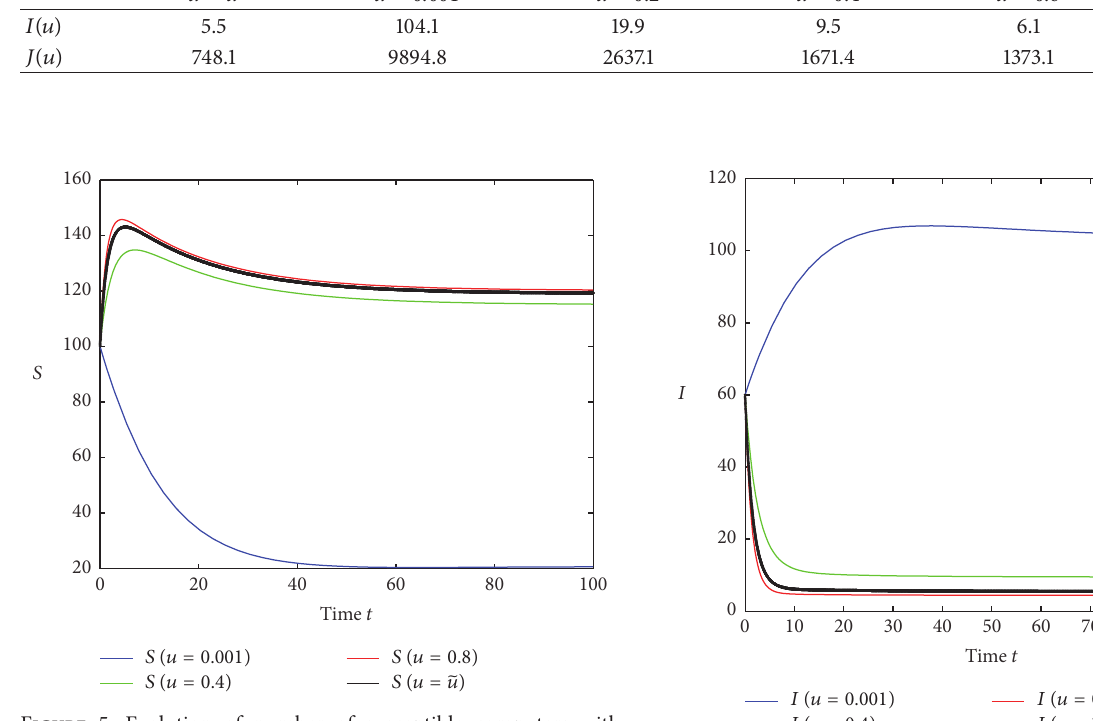
Figure 5: Evolution of number of susceptible computers with different control strategies.